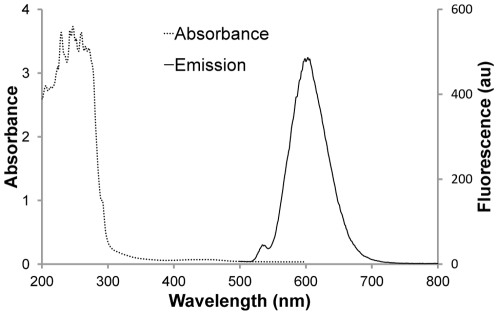
The absorbance and emission spectra of Ru(II)-protein G conjugates.The absorbance spectrum (dotted line) was scanned from OD200 to OD600. The emission spectrum (solid line) was scanned from 500 nm to 800 nm using 452 nm excitation wavelength.